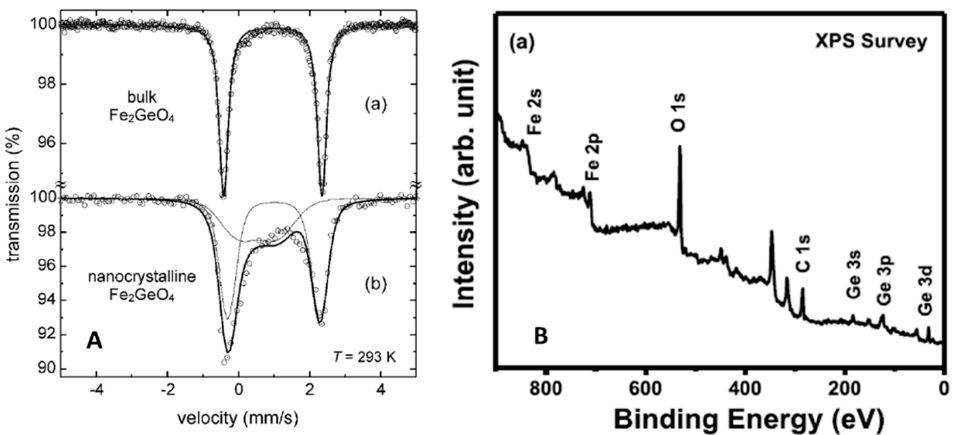
Figure 5. ( A ) Mossbauer spectra from bulk and nanocrystalline GFO [27]. Reproduced with permis- sion, Copyright De Gruyter 2008; ( B ) XPS survey spectrum of polycrystalline GFO [28]. Reproduced with permission, Copyright Elsevier 2019.